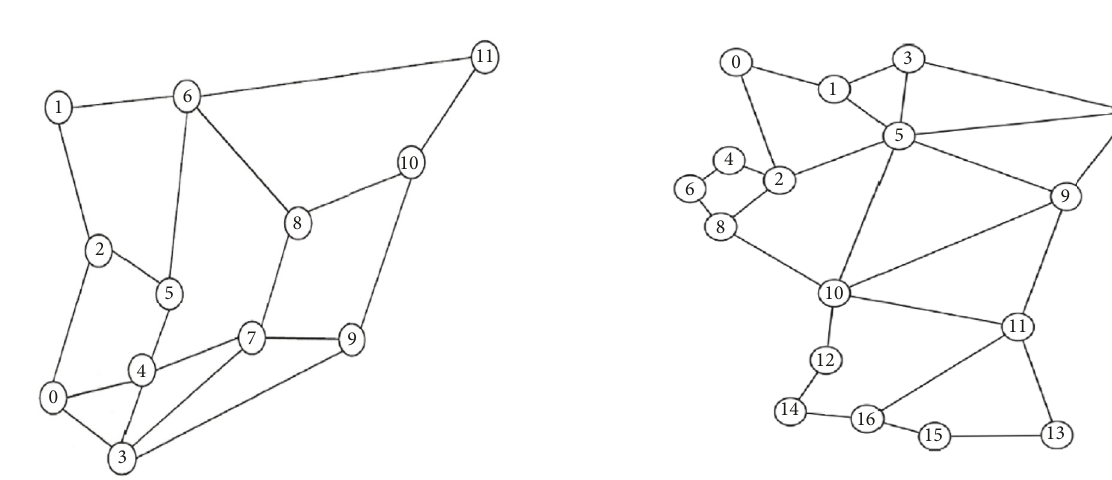
Figure 7: Finland topology with 12 nodes and 19 fiber links.